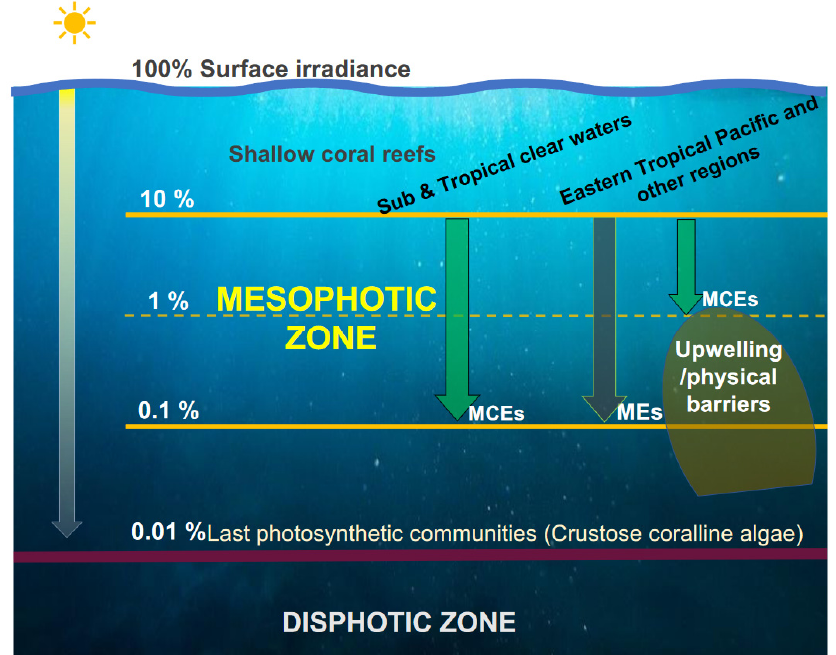
Figure 8. Total ranges of photosynthetic communities in the percentage of surface irradiance (Es%). In the middle of this variability (mesophotic zone), the MCEs or MEs are developed. In the Mexican Pacific and most of the ETP, the MCEs are limited in the upper mesophotic zone, while the clearest waters reach the bottom of the lower mesophotic zone.